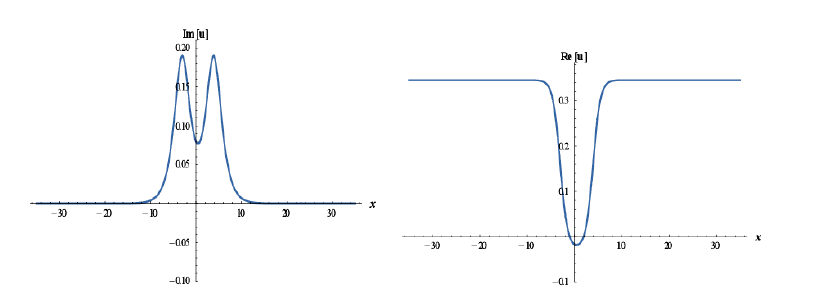
Figure 4. Contour graphs of imaginary and real part of (20).